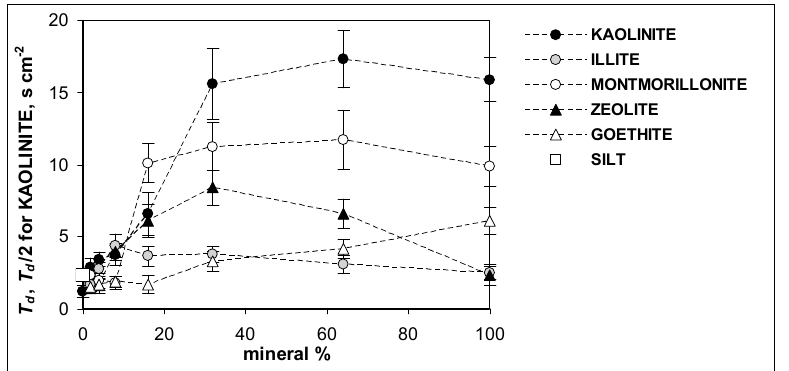
Figure 5. Dependence of the average values of time necessary to destroy the unit surface of the aggregate on the added minerals’ percentage. Error bars are standard deviations. Note that the data for kaolinite are divided by two to make the figure more readable.